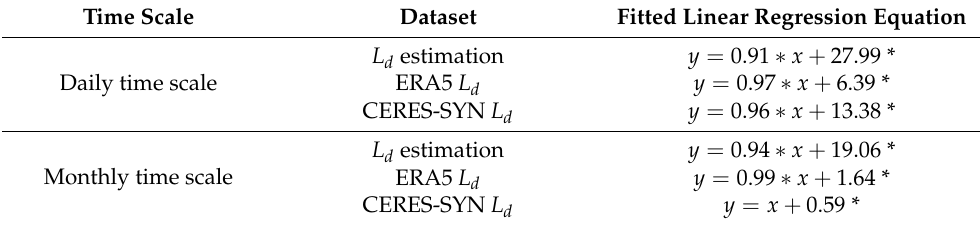
Table 3. The fitted linear regression equations for the generated, ERA5, and CERES-SYN L d datasets on both daily and monthly time scales. Where the x and y represent the ground measurements of L d and the L d estimates,